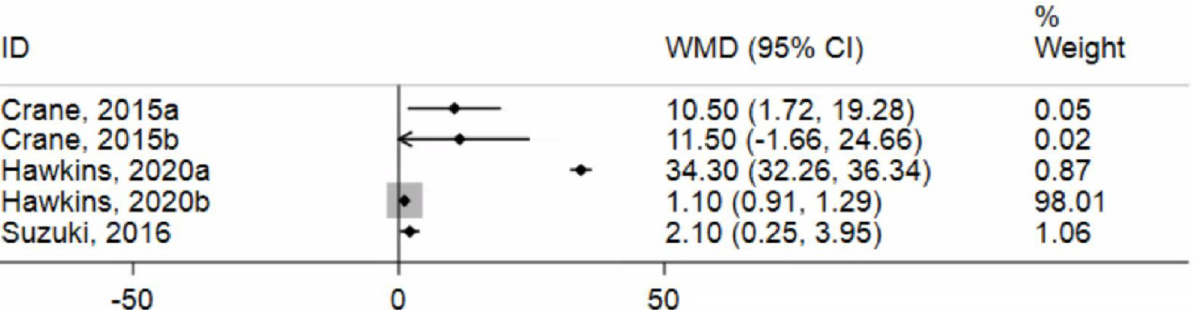
Fig 5. Forest plot of included IPSCs studies. References: Suzuki [28]; Hawkins [30]; Crane [29].